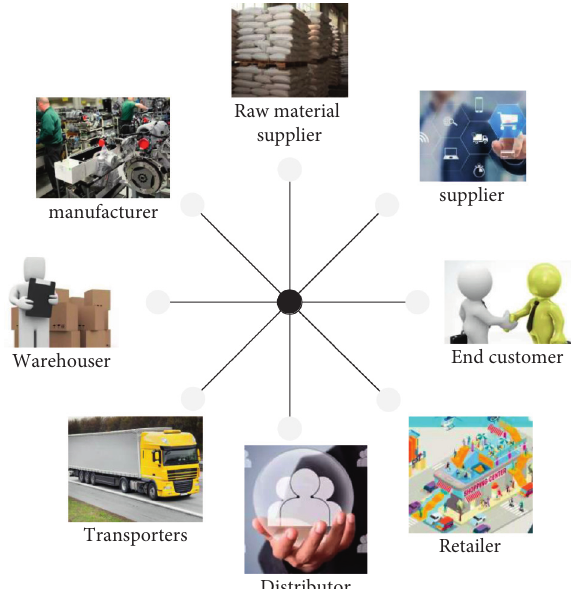
Figure 1: The structure of the supply